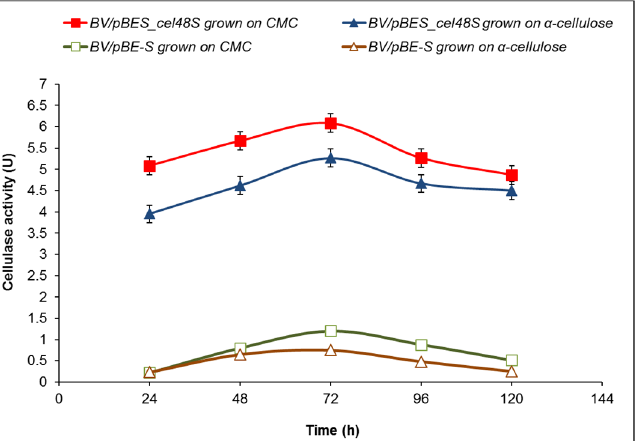
Figure 7. Time course of cellulase activity of B. velezensis recombinants bearing the expression vector pBE-S or the construct pBES_cel48S (clone 6). The fermentation media contained 10 g/L CMC or 10 g/L α -cellulose. The data presented are mean values of three batch processes.